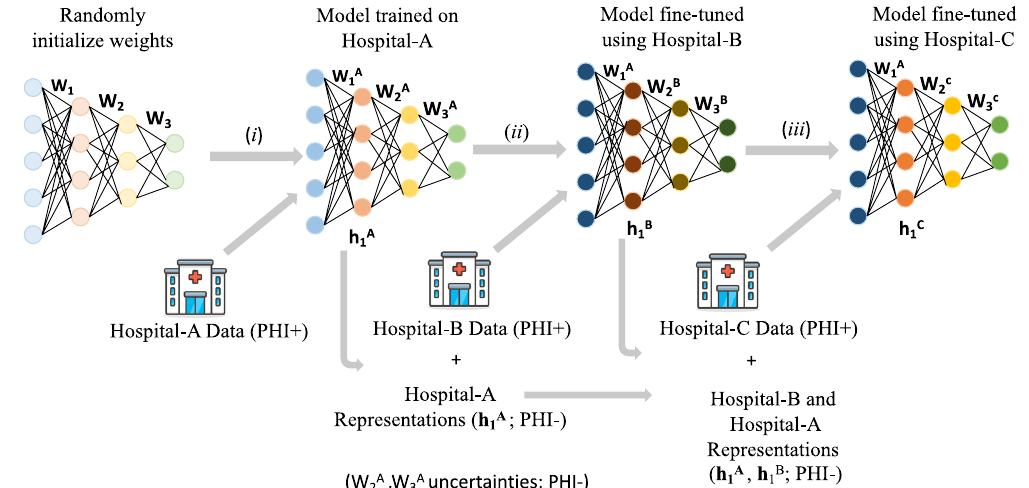
Figure 1. Schematic diagram of the WUPERR algorithm. The training starts with a randomly initialized set of weights, which are trained on the first task (e.g., prediction on Hospital-A data). In all subsequent learning A tasks the input layer weights ( W 1 ) are kept frozen. The optimal network parameters, the parameter uncertainties A under task-A, and the set of representations from training cohort of Hospital-A ( { h 1 } ) are then transferred to Hospital-B. The deeper layers of the model are fine-tuned to perform the second task (e.g., prediction on Hospital-B data) through replaying the representation of Hospital-A and Hospital-B data. Similarly, the optimal parameters and their uncertainty levels along with the Hospital-A and Hospital-B representations are transferred to Hospital-C to fine-tune the model on performing the third task. Note, at no time protected health information (PHI+) leaves the institutional boundaries of a given hospital. Finally, at the time of evaluation (on testing data) at a given task, the model is evaluated on all the hospital